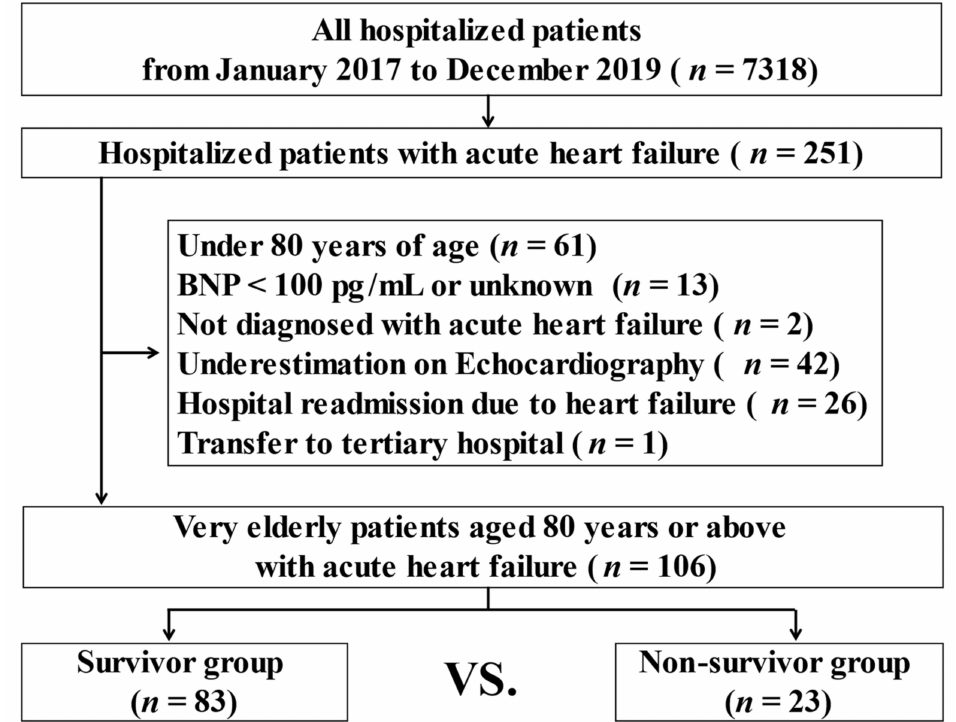
Figure 1. Study flow chart. BNP: brain natriuretic